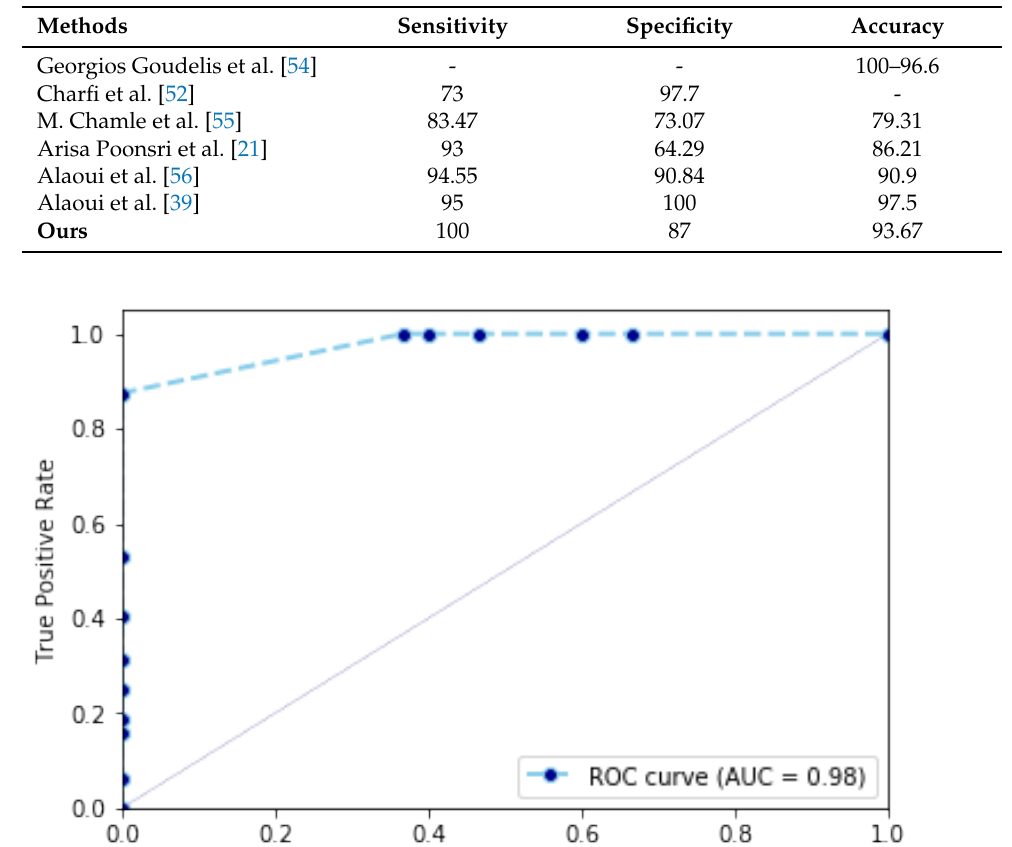
Table 2. Charfi dataset: Sensitivity, specificity and accuracy of our work in comparison to state-of- the-art methods.